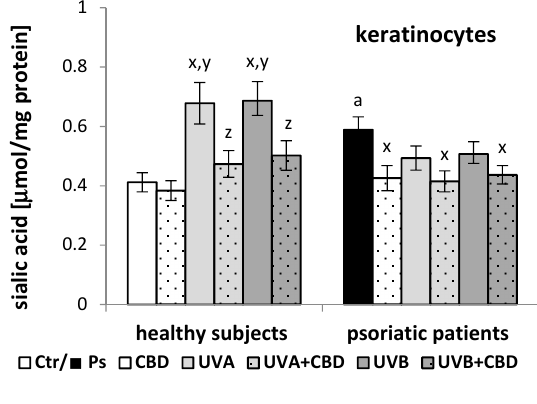
compared to irradiated cells without CBD treatment. However, greater changes were observed in the cells derived from healthy people.